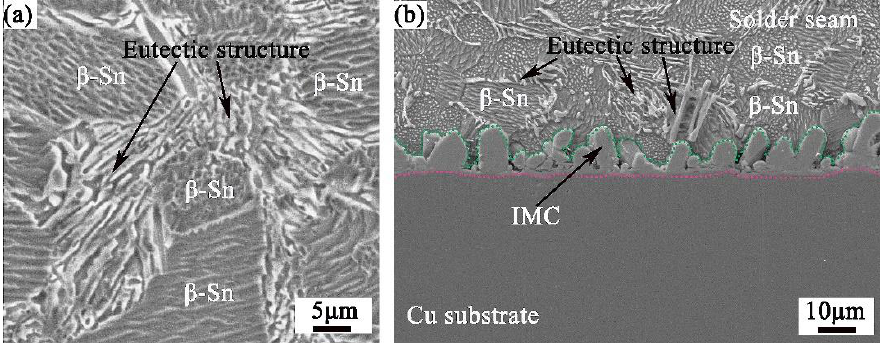
Figure 4. Solder seam ( a ) and interface microstructure ( b ) of Sn2.5Ag0.7Cu0.1RE0.05Ni/Cu solder joint before thermal cycles.